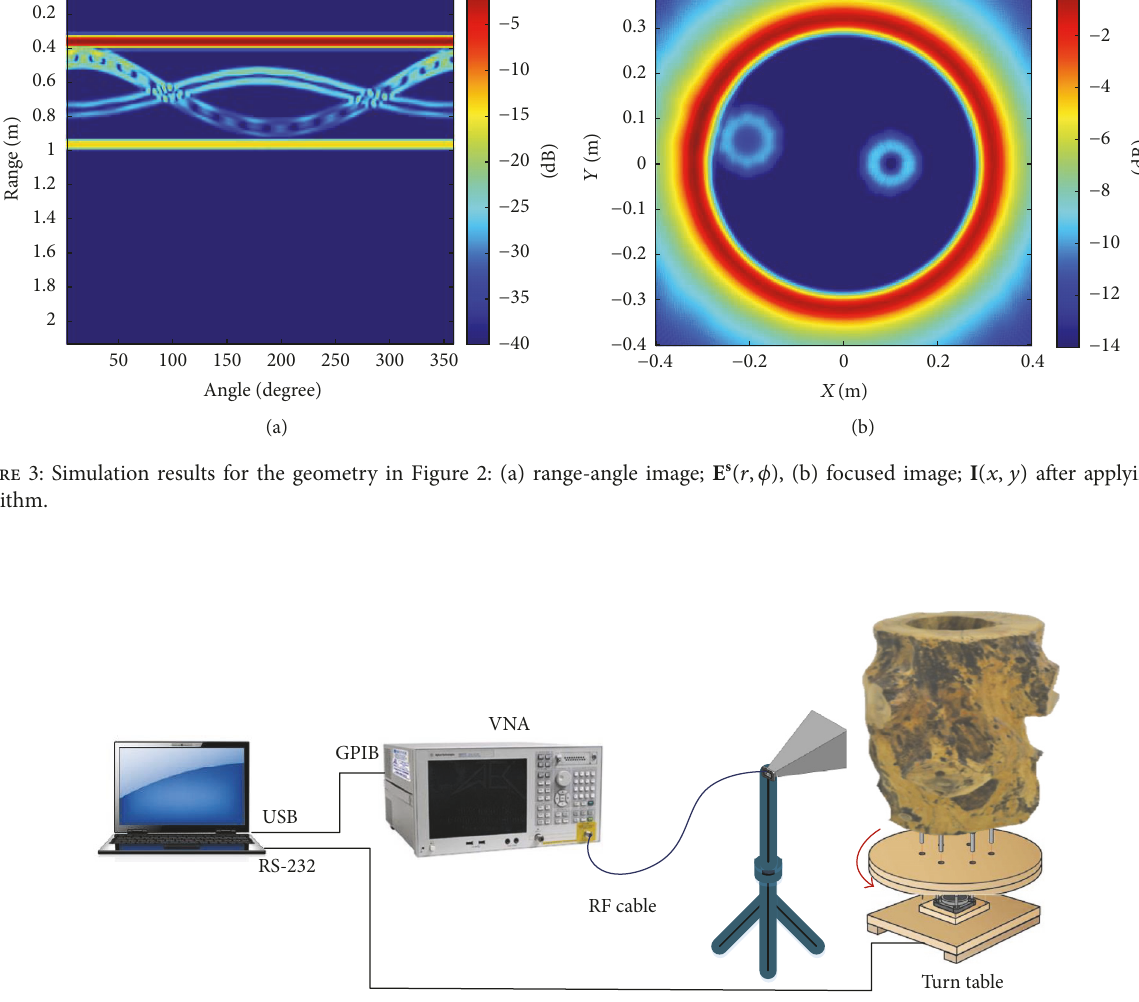
Figure 4: The measurement set-up for the TIIR